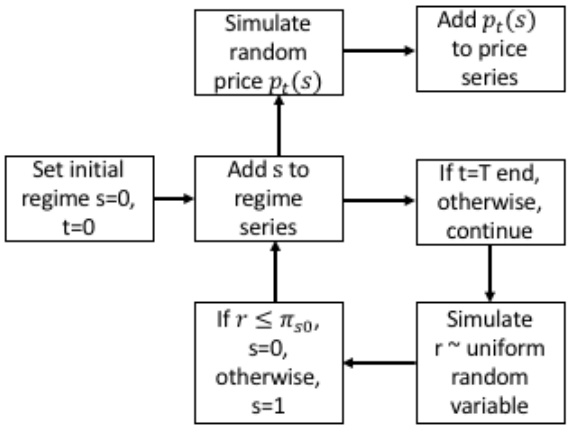
Figure 3. The regime switching model